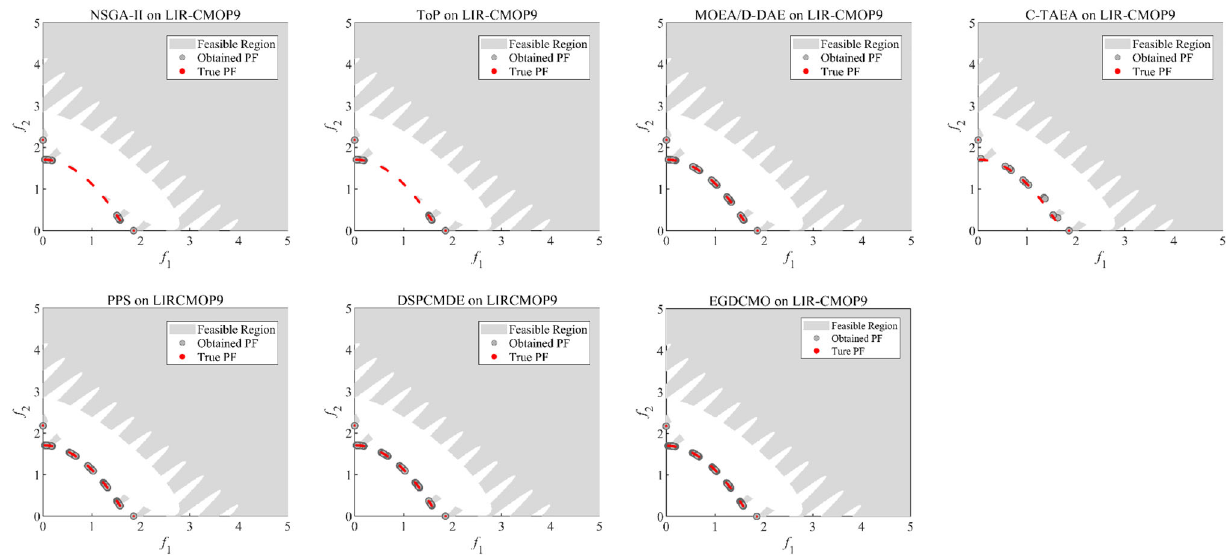
Fig. 15 Pareto front with median IGD value obtained by the proposed EGDCMO and all the compared CMOEAs on